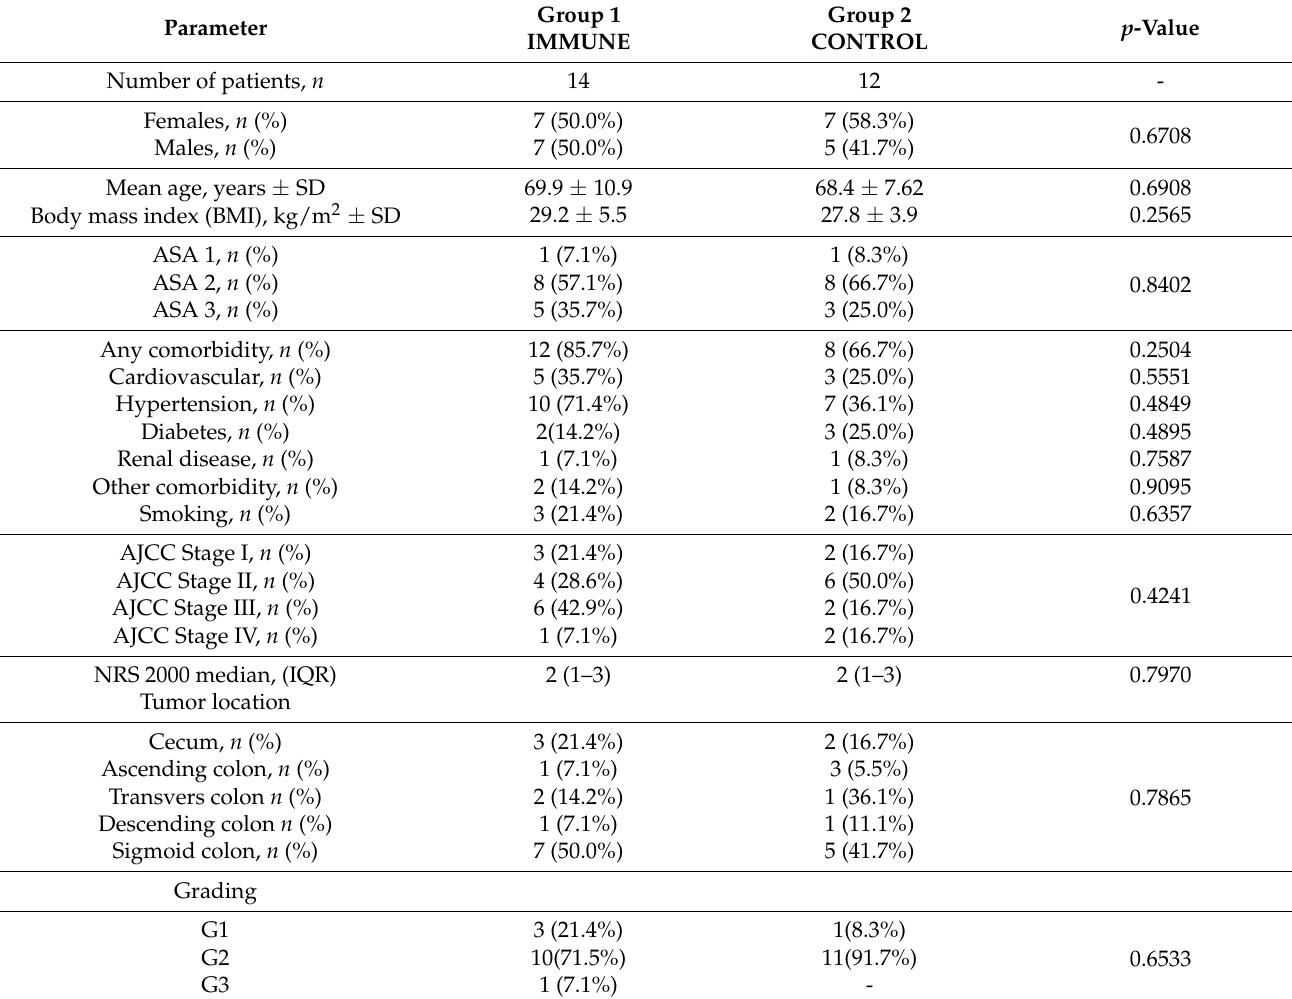
Table 1. Demographic analysis of patient